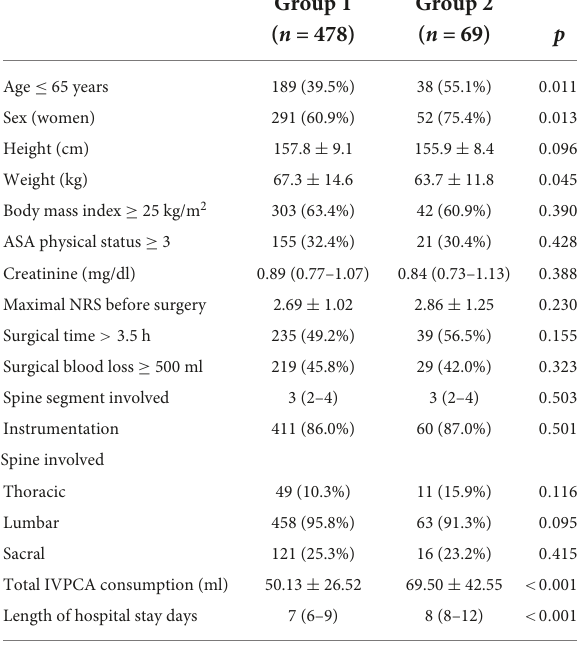
TABLE 1 Comparisons of patient characteristics between the two postoperative pain trajectory groups after spine